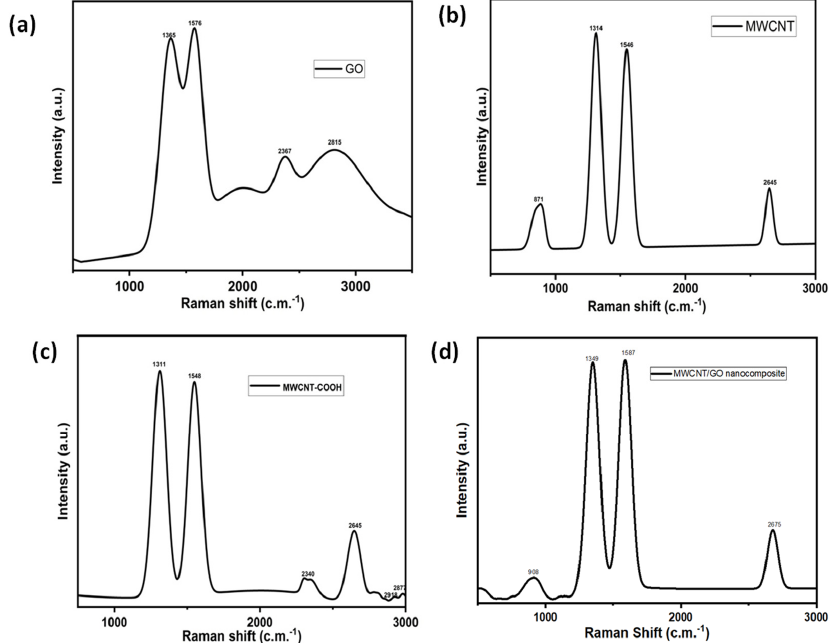
Figure 1. Raman spectra of ( a ) GO, ( b ) MWCNT, ( c ) MWCNT − COOH, and ( d ) the MWCNT/GO nanohybrid.